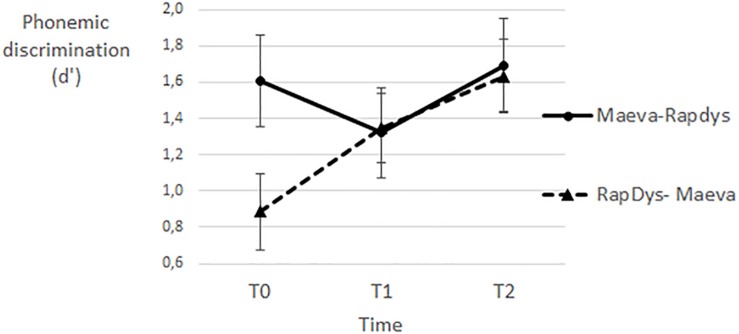
Phonemic discrimination peaks (at 0 ms along the VOT continuum; in d’ values) for each time period (pre-training, post-training 1; post-training 2) and each presentation order (left: R–M, right: M–R).